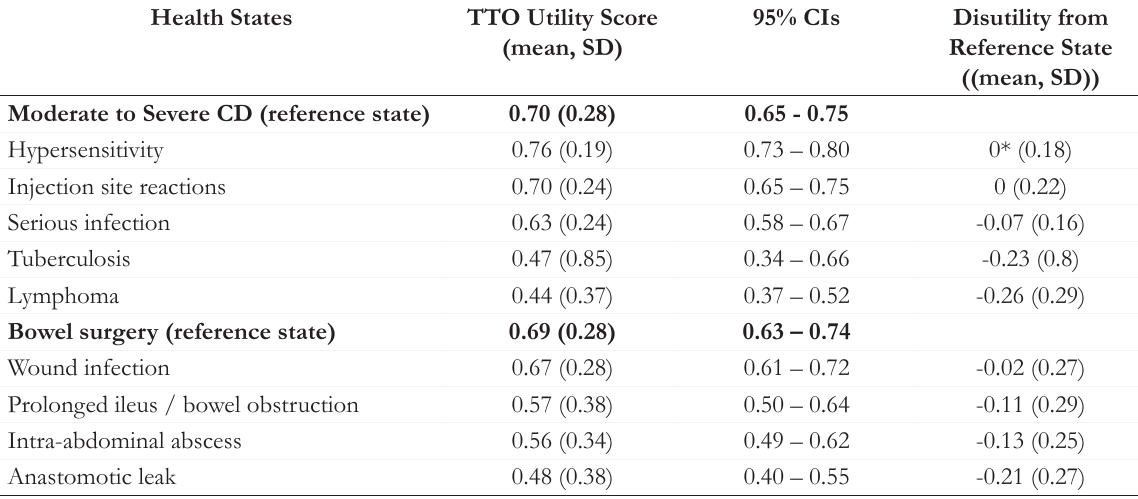
Table 2: Mean TTO Scores from Reference State (Moderate to Severe CD) for all Health States (Best to Worst)